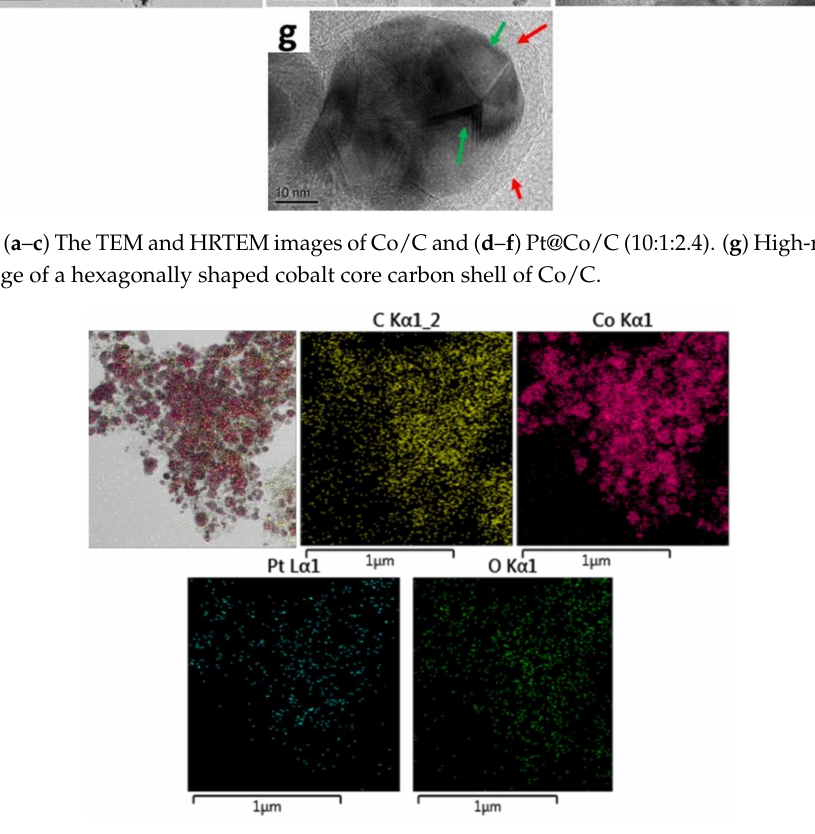
Figure 6. STEM elemental mapping of the Pt@Co/C